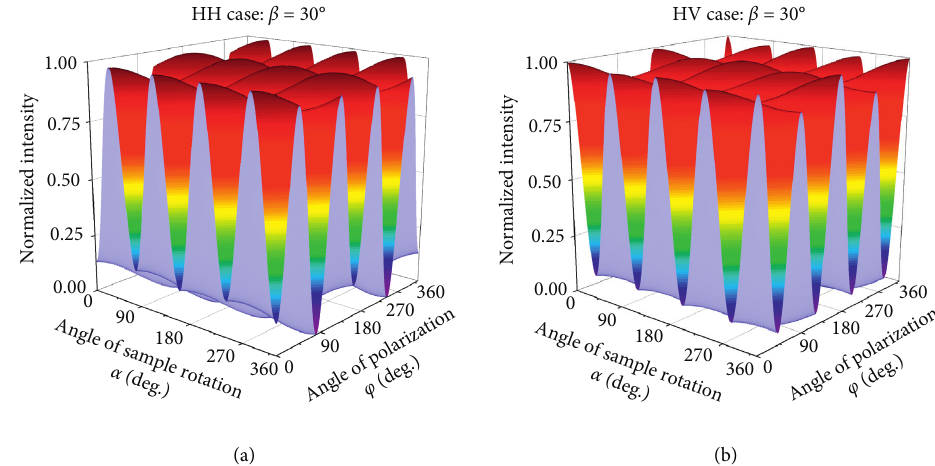
Figure 7: Raman intensity distribution under the oblique backscattering configuration ( β � 30 ° ) for different sample rotation angles α and polarization directions φ in the (a) HH case and (b) HV case.